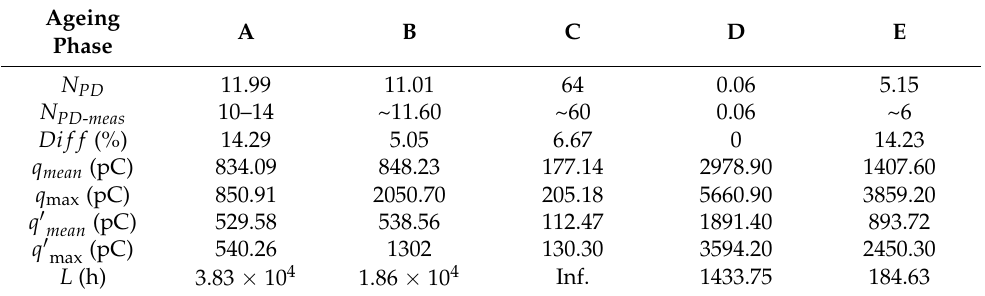
Table 2. Summary of the typical simulation results at the five ageing phases